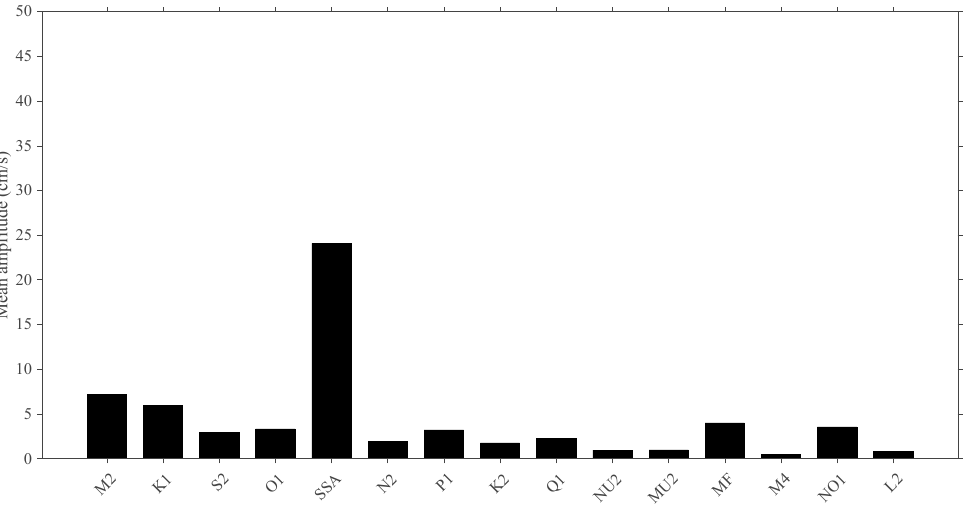
Figure 13. The mean current ellipse major axis magnitude (in cm/s) for 15 constituents from the HFR over the entire domain. Tidal characteristics are classified according to the form ratios given in Table 4. The types of classifications based on the form ratio are taken from Courtier [36]. The form ratio Table 4. Classification types of tidal characteristics. represents the ratio of the sum of the amplitudes of the major diurnal components (K 1 and O 1 ) to the sum of the amplitudes of the major semidiurnal components (M 2 and S 2 ), as defined by [37]